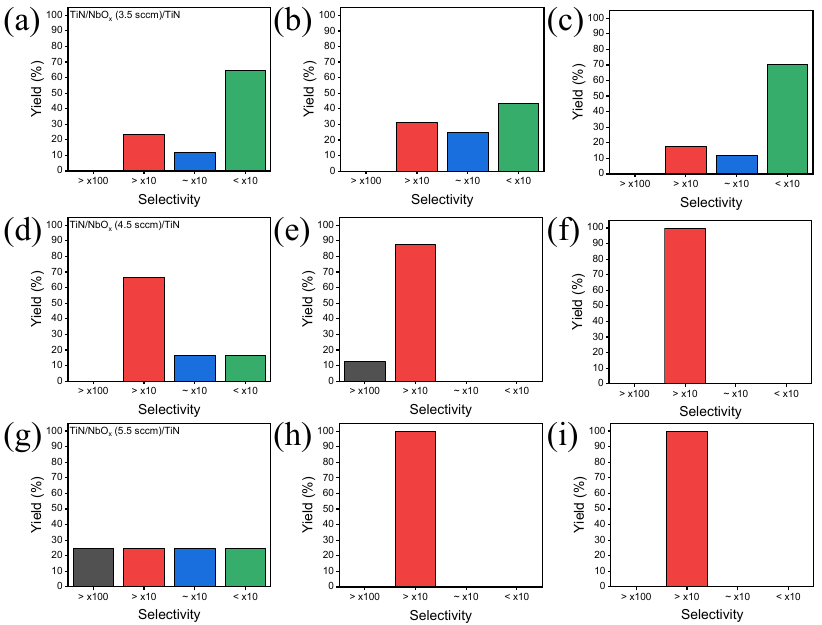
Figure 3. Selectivity of TiN/NbOx/TiN devices: ( a ) 3.5 sccm, 7 min, ( b ) 3.5 sccm, 10 min, ( c ) 3.5 sccm, 13 min, ( d ) 4.5 sccm, 7 min, ( e ) 4.5 sccm, 10 min, ( f ) 4.5 sccm, 13 min, ( g ) 5.5 sccm, 7 min, ( h ) 5.5 sccm, 10 min, and ( i ) 5.5 sccm, 13 min (oxygen flow, sputtering time).